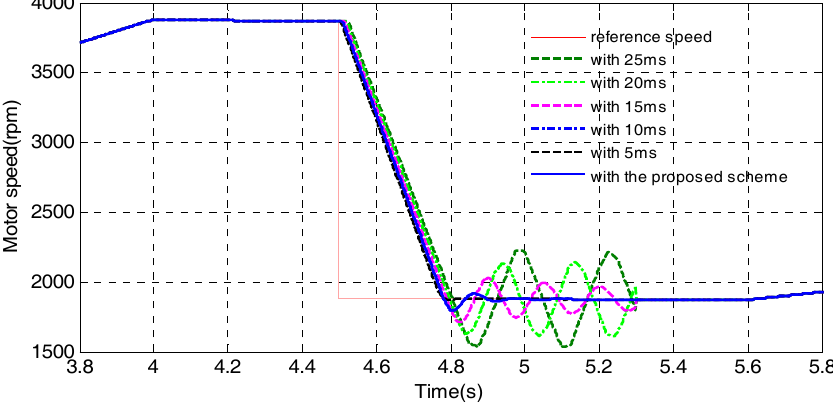
Figure 7. The upshifting process with different periods in simulations.